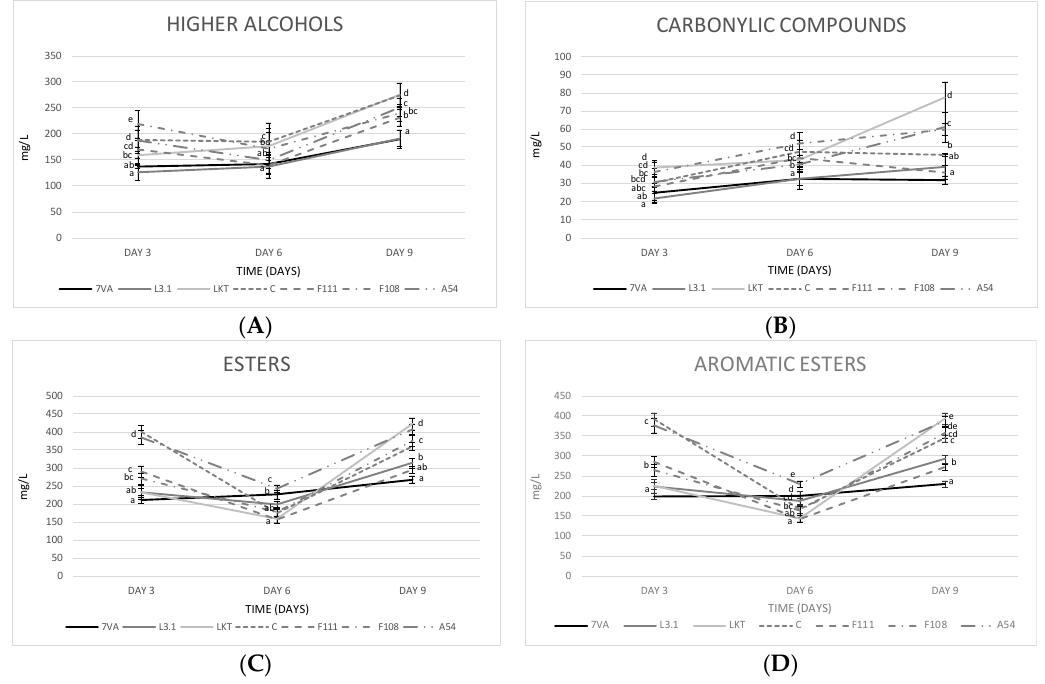
Figure 6. Monitorisation of the fermentative volatiles: ( A ) higher alcohols, ( B ) carbonyl compounds, ( C ) esters and ( D ) aromatic esters on days 3, 6 and 9 of fermentation. Values are means ± sd ( n = 3). Different letter on the same day of fermentation means significant differences ( p < 0.05). Concerning carbonyl compounds (Figure 6B), yeasts Laktia (77.67 ± 8.5 mg / L) and